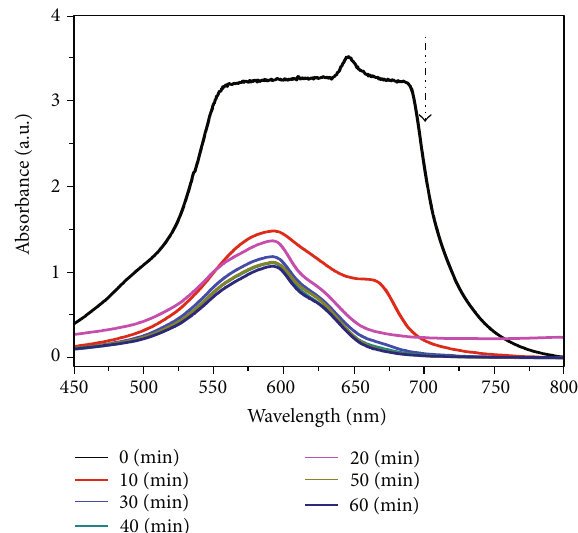
Figure 7: Absorption spectrum representing time-dependent removal of methylene blue dye using sintered incense stick ash product.